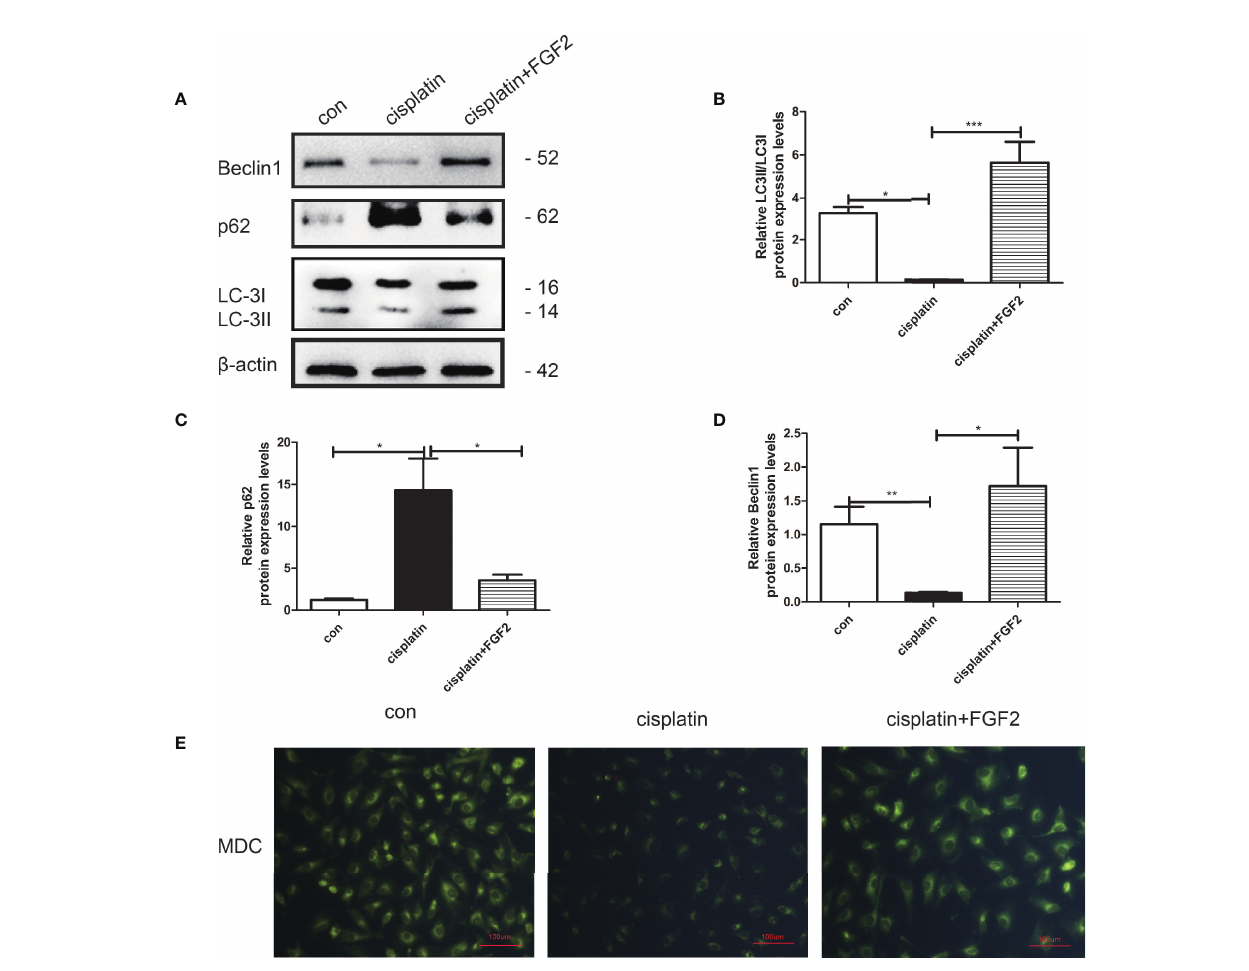
FIGURE 2 | FGF2 promoted autophagy in injured KGN cells. (A – D) Western blot assay was used to assay LC3, Beclin1, and p62 expression. The results indicated that compared to the control groups, the autophagy was decreased in cisplatin-induced injured KGN cells. When injured KGN cells were treated with FGF2, the autophagy increased. (E) Representative images of KGN cells were treated with cisplatin and cisplatin plus FGF2, and then cells were stained with MDC (scale bar: 100 m m). One-way ANOVA followed by Tukey ’ s multiple comparison test. The results were shown as mean ± SEM from 3 independent experiments ( a = 0.05, * P